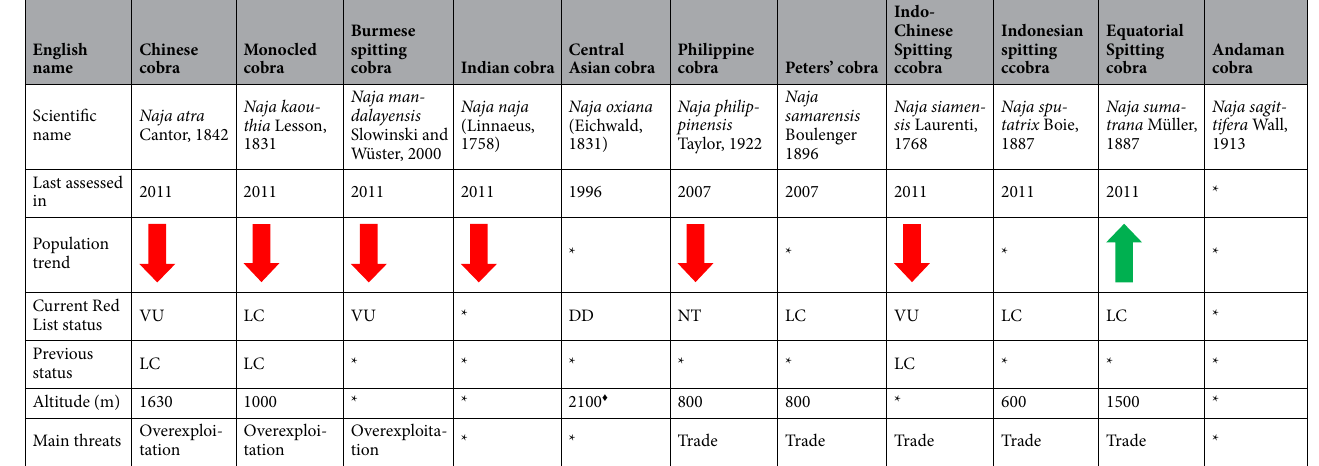
Table 3. Current conservation status and threats of 11 Asian cobras extracted from IUCN 17 database. *No published information. ♦ 39